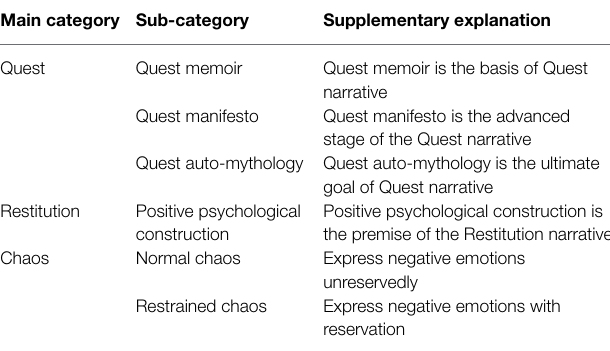
TABLE 3 | The axial coding scheme of pandemic diary